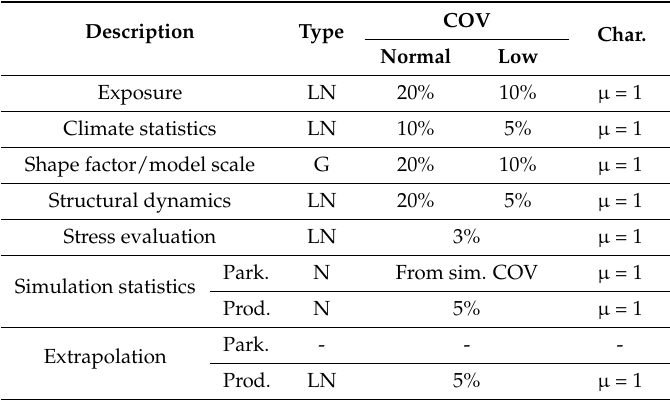
Table 2. Epistemic uncertainties from